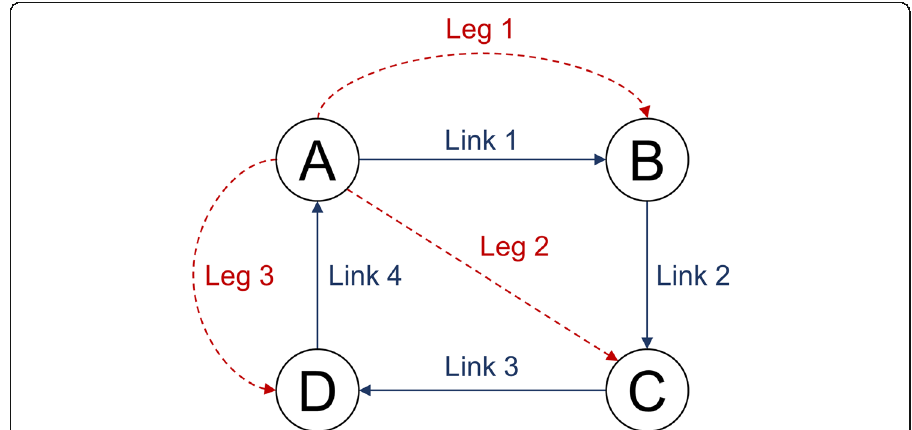
Fig. 1 Liner service links and corresponding